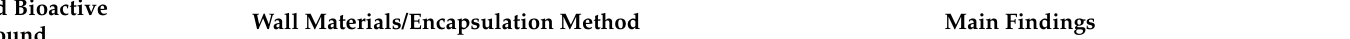
Table 2. Encapsulated bioactive compounds from agri-food wastes and possible applications in the food